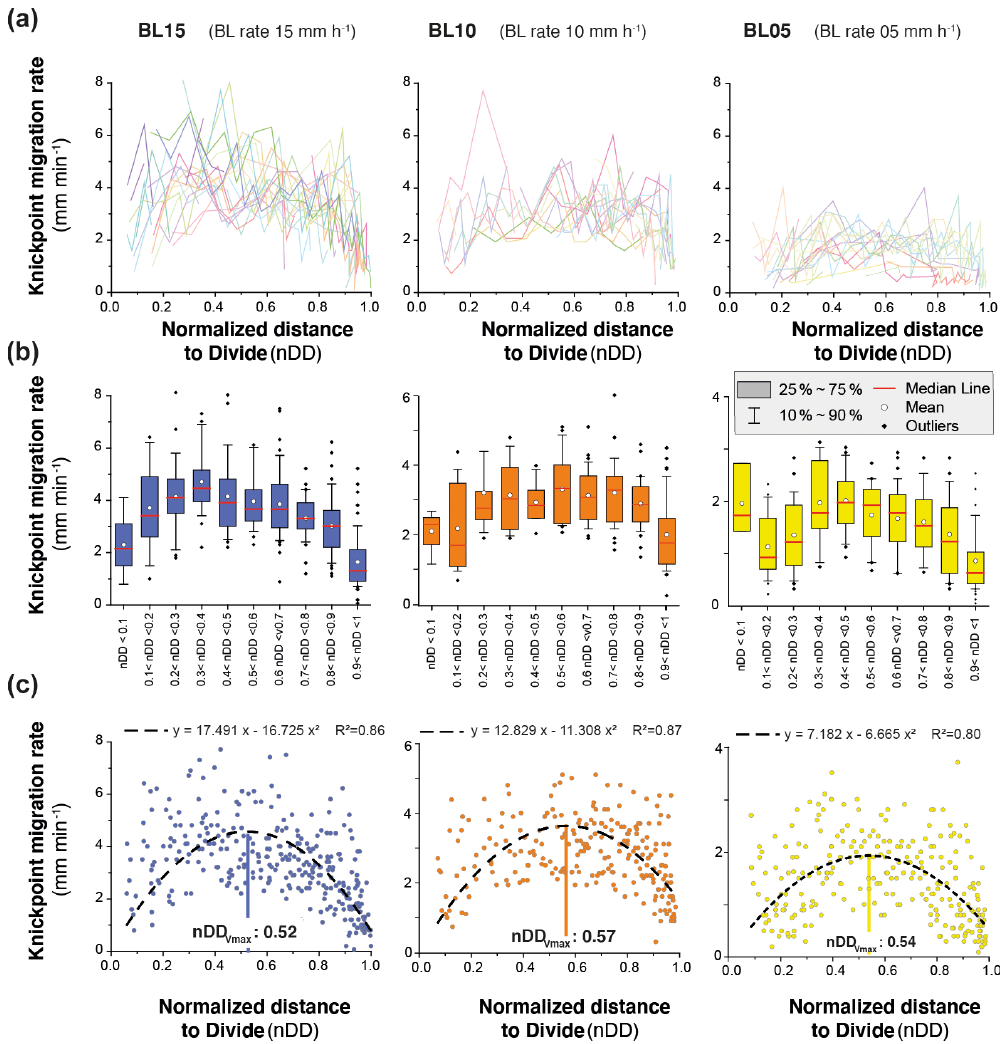
Figure 9. (a) Knickpoint retreat rates according to the normalized distances to divide (nDD) for each knickpoint of experiments. Each color line corresponds to an individual knickpoint of the space–time diagram in Fig. 8. Note that the scale on the y axis is the same for all graphs. (b) Summary statistics of retreat rates for nDD intervals of 0.1. Note the change in scale on the y axis between the graphs. (c) Plot of all knickpoint retreat rates for each experiment. Note the change in scale on the y axis between the graphs. Dashed black line shows the second- order polynomial fit to the data used to define the normalized longitudinal distance of maximum velocity of knickpoints (nDD V Fig.